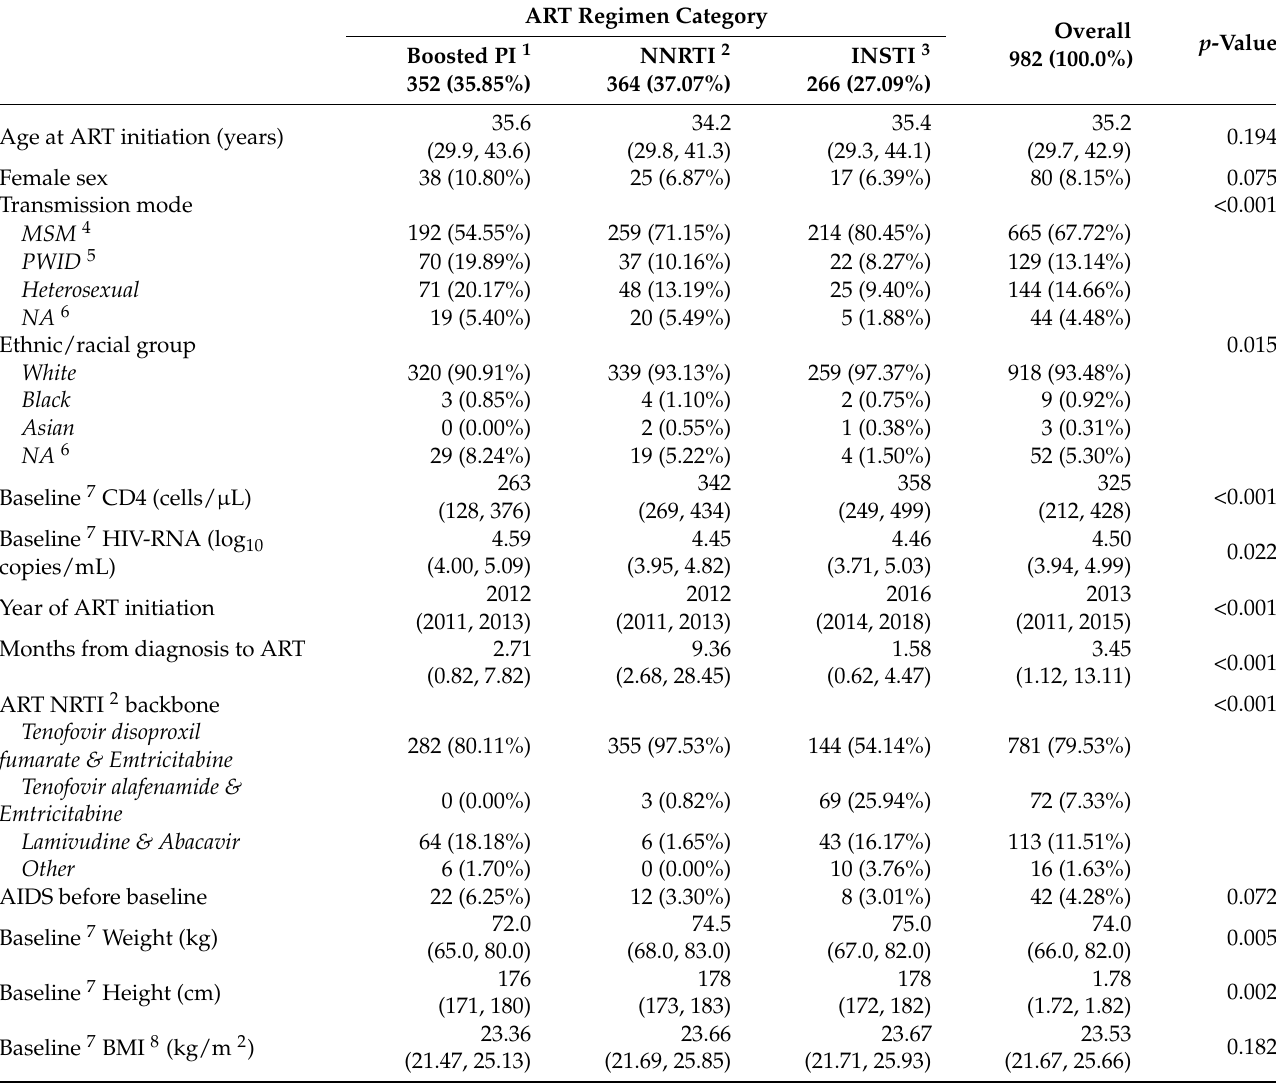
Table 1. Demographic, clinical and follow-up characteristics of the study sample ( n = 982) by ART regimen category. All figures are mdian (IQR) or n